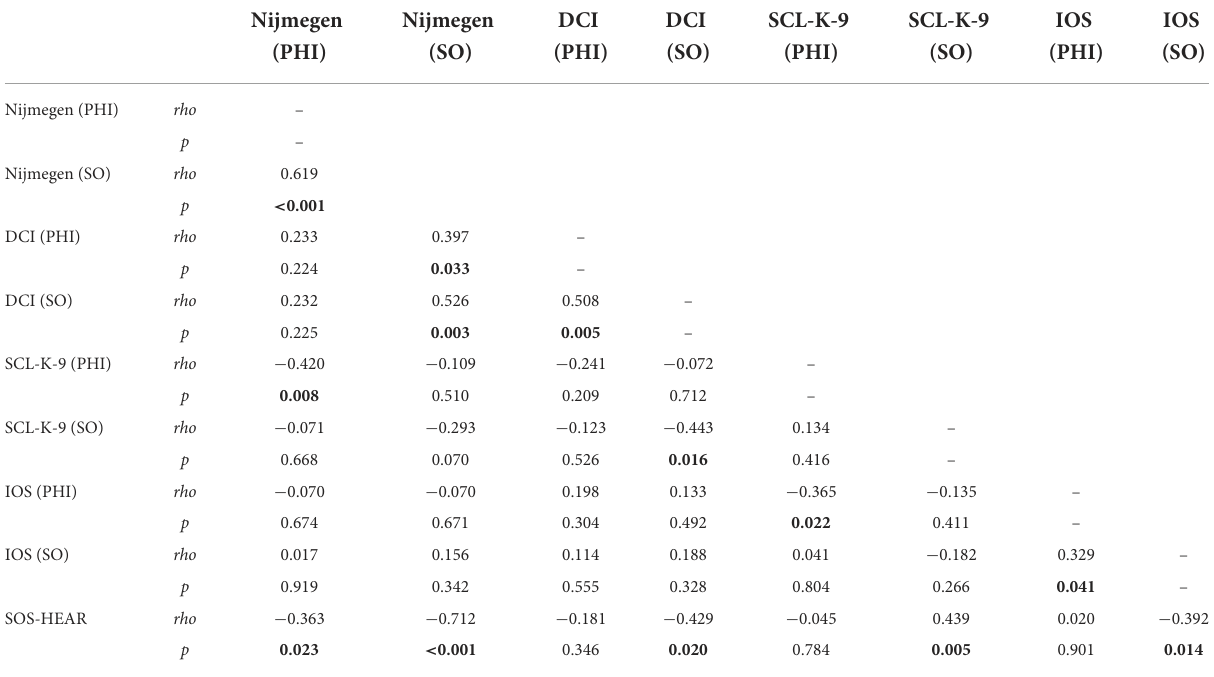
TABLE 6 Correlation between the questionnaires of spouses ( N =